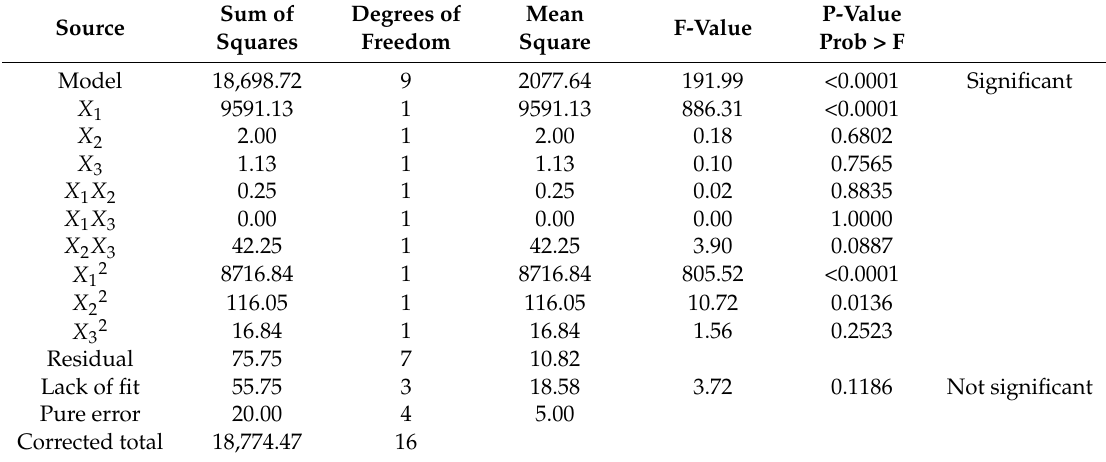
Table 5. Analysis of variance (ANOVA) of flexural strength for selected experimental correlation using RSM.